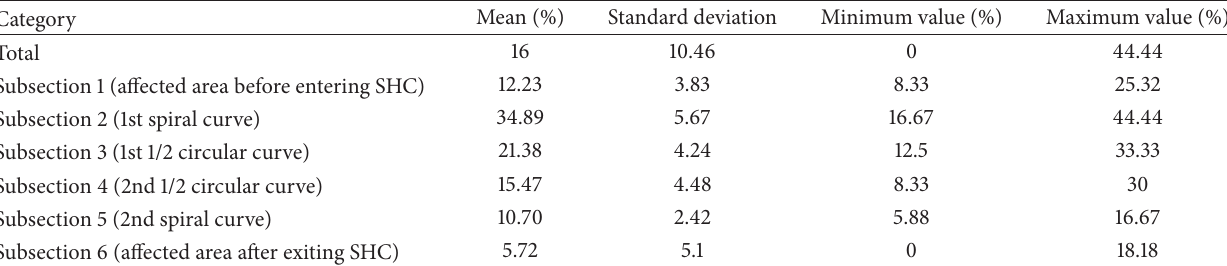
Table 3: Normalization processing results of crashes of